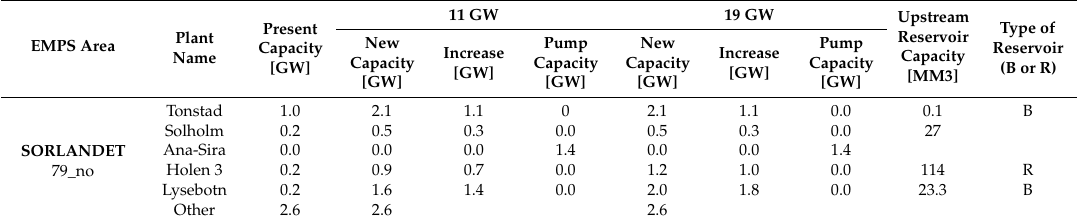
Table 1. Increases of production capacities and pumped storage in Southwestern Norway